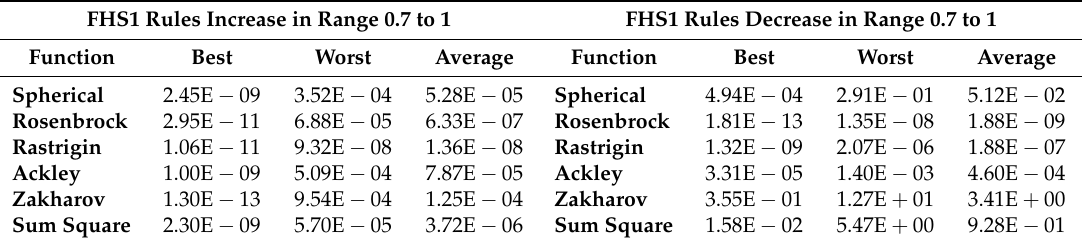
Table 4. Results obtained with FHS1 using fuzzy logic to increase and decrease HMR with a range from 0.7 to 1, applied to six benchmark mathematical functions.